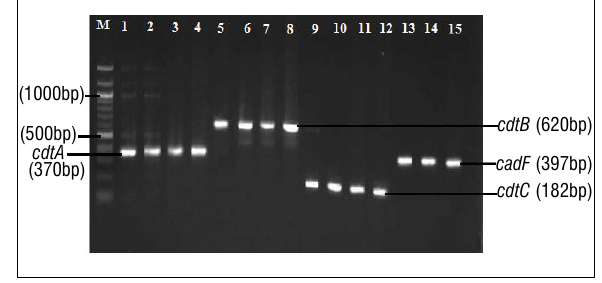
Figure 1: Colonies of Campylobacter on blood agar.